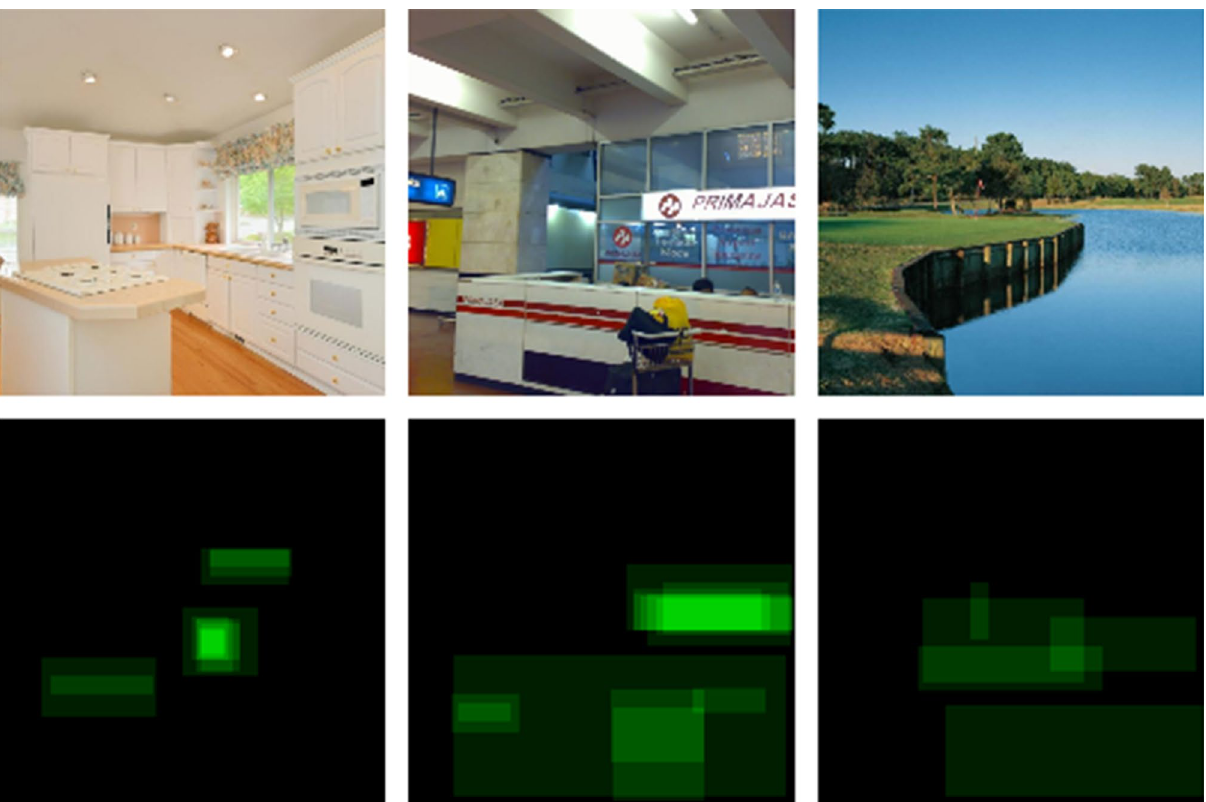
Figure 8. Images from VISCHEMA 2 dataset are shown in the top row, while in the bottom row are the image regions indicated by observers as causing them to remember the images from above. Source images are drawn from the public SUN dataset 30